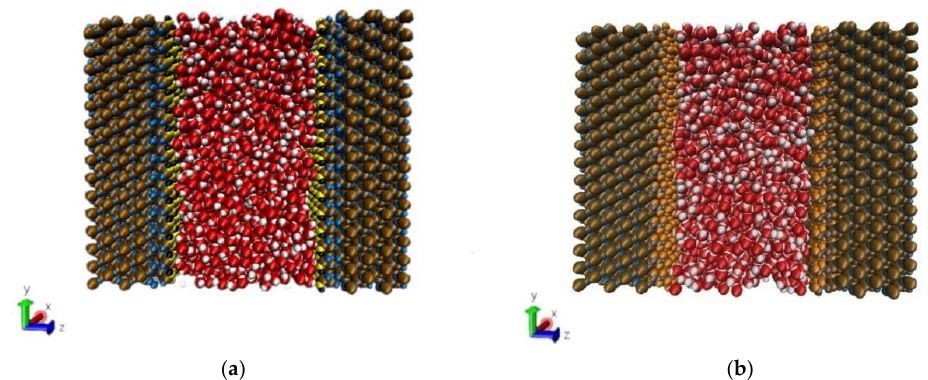
Figure 4. Micro-flow system in a nanochannel: ( a ) hydroxylated nanochannel; ( b ) silanized nanochannel. Color legend: silicon Si (ochre), SiO 2 oxygens O SiO2 (blue), hydroxide oxygens O hy (yellow), and hydroxide hydrogens H hy (black), alkyl chain C ( ch2/ch3 ) (gray), alkyl chain H ( ch2/ch3 ) (orange), water O w (red), water H w (white).